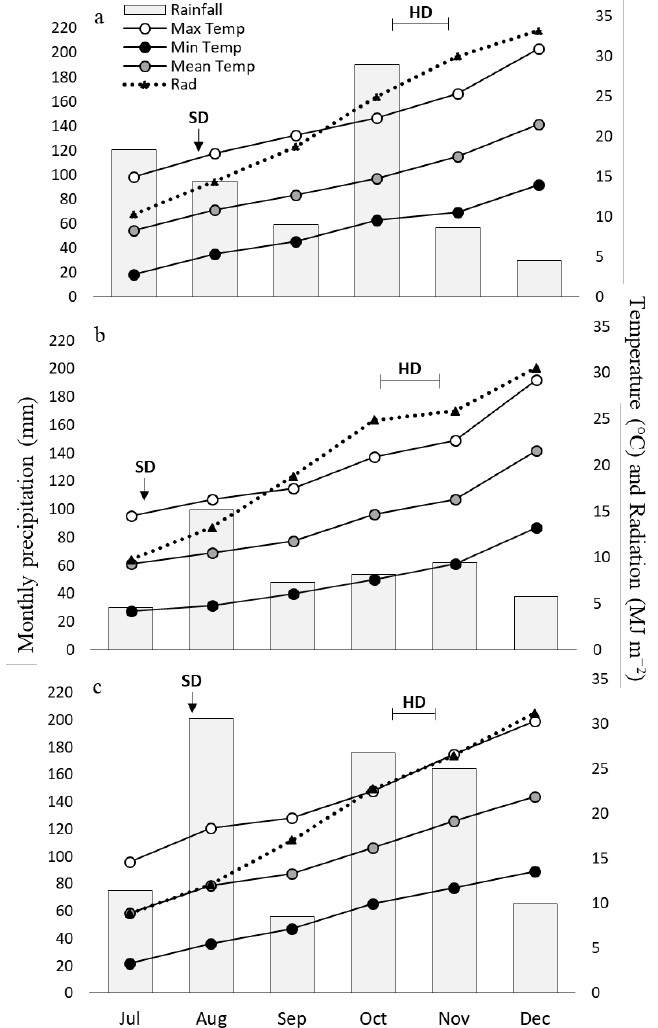
Figure 1. Monthly precipitation, maximum, minimum and mean temperatures and mean global solar radiation values during each growing season (( a ) Cabildo 2014, ( b ) Barrow 2017 and ( c ) Pieres 2014). SD: sowing date; HD: heading date; Temp: temperature; Rad: radiation.